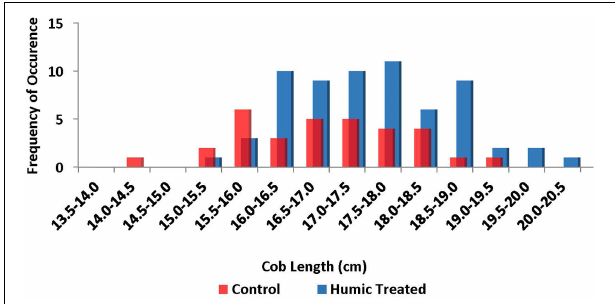
FIGURE 4 | Distribution of cob lengths at physiological maturity for plant samples hand-collected from all treatment strips in all 4 years. Both application rates of the humic product are grouped together into “Humic Treated.” Total number of samples is 32 for the control and 64 for both humic product application rates